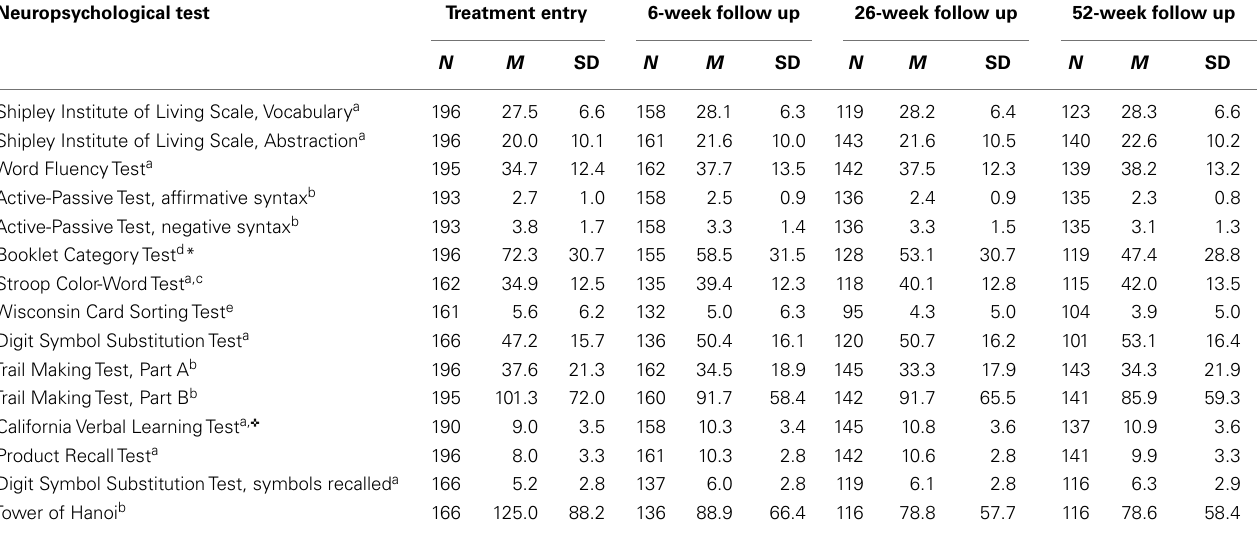
Table 1 | Performance on component tests of the neuropsychological assessment battery at treatment entry and at each follow up. Neuropsychological test Treatment